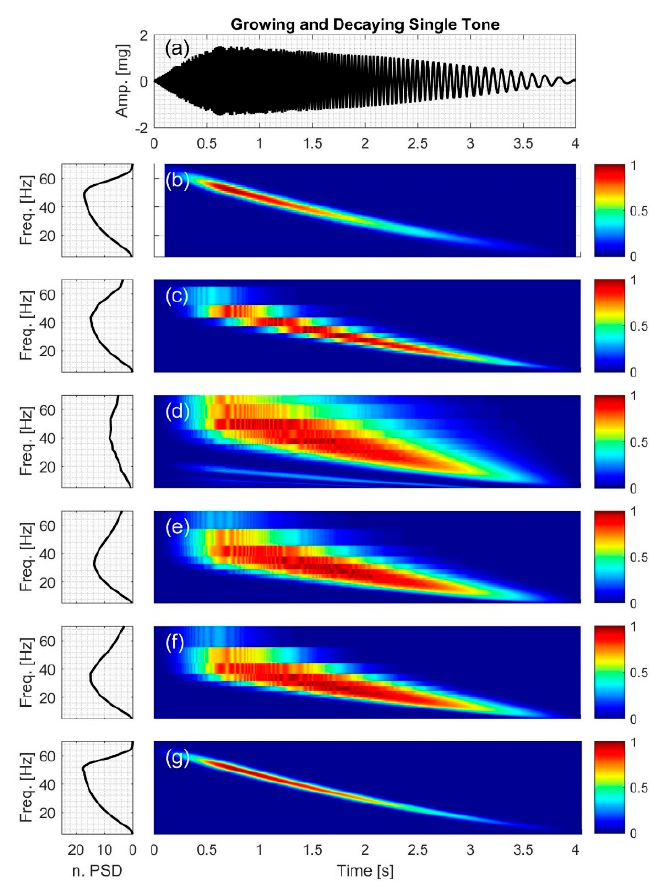
Figure 8. Synthetic test signal with growing and decaying single tone with varying frequency: ( a ) Time series. Left and right columns show the power spectral density and time-frequency distribution of the signal using: ( b ) STFT; ( c ) CWT-Morl; ( d ) CWT-Haar; ( e ) CWT-db4; ( f ) CWT-Coif5, and ( g ) PCT, respectively.